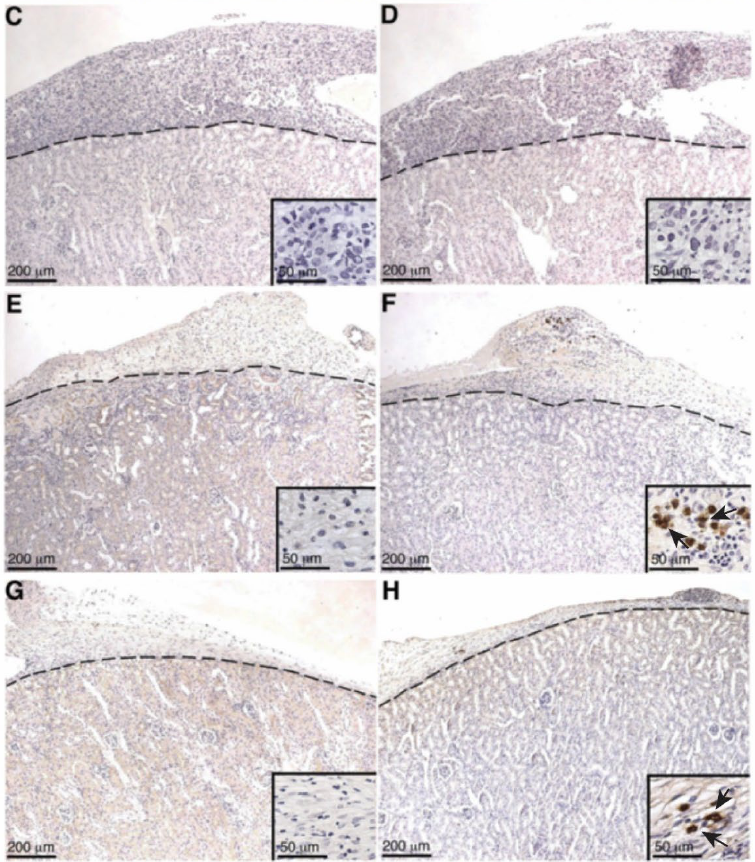
Figure 6. Deposition of antibodies (IgG or IgM) on MSC-1 grafts. Tissue sections were collected at days 2 ( A , B ), 5 ( C , D ), 14 ( E , F ), and 20 ( G , H ) post transplantation and immunostained for IgG (brown; A , C , E , G ) or IgM (brown; B , D , F , H ). Insets are higher magnifications. A dotted line separates the graft (above the line) from the kidney (below the line). Sections were counterstained with hematoxylin (blue). Arrows indicate examples of positive staining.